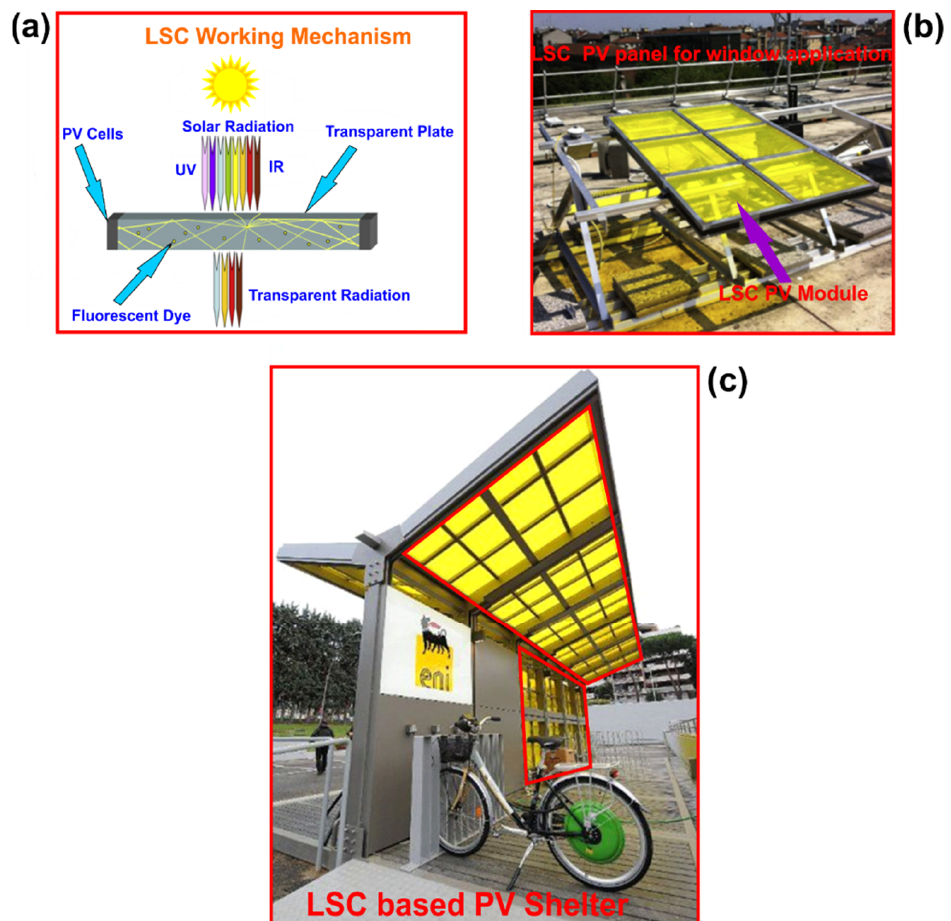
Figure 5. ( a ) The working mechanism of an LSC PV module (source: ENI Donegani Institute) (reproduced and modi fi ed with permission from Refs.[74,75], ( b ) LSC-based window for BIPV (reproduced and modi fi ed with permission from Refs. [74,75], and ( c ) LSC-based BIPV shelter in Rome, Italy (reproduced and modi fi ed from [61,73]).